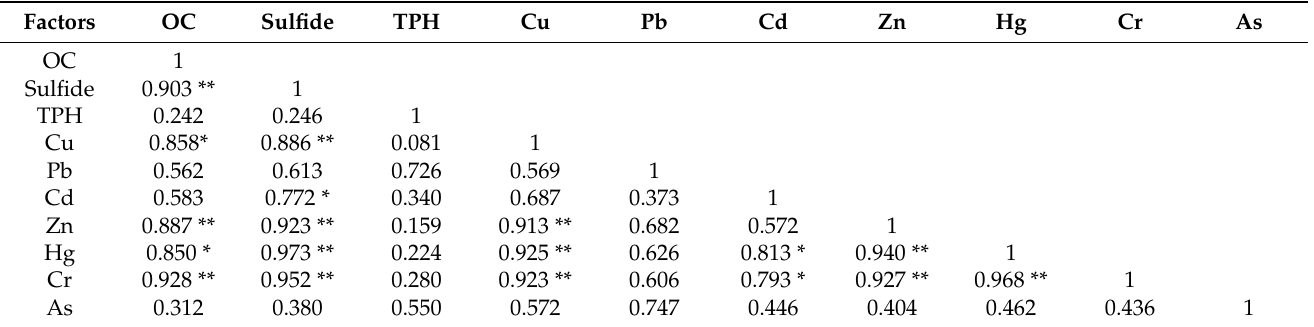
Table 5. Correlation analysis between factors in surface sediments.